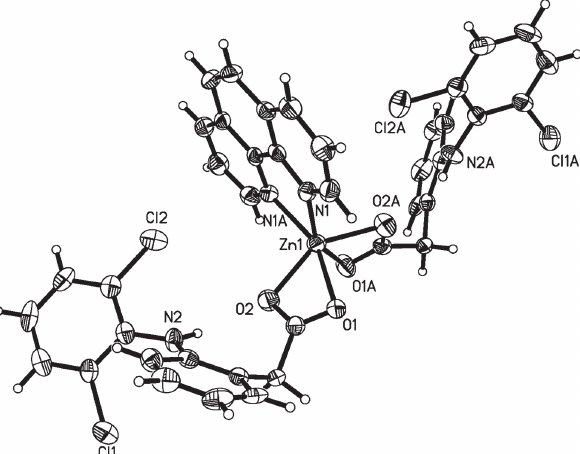
figure. Table 1 contains crystallographic data and Table 2 con- tains the list of the atoms including atomic coordinates and displacement parameters.